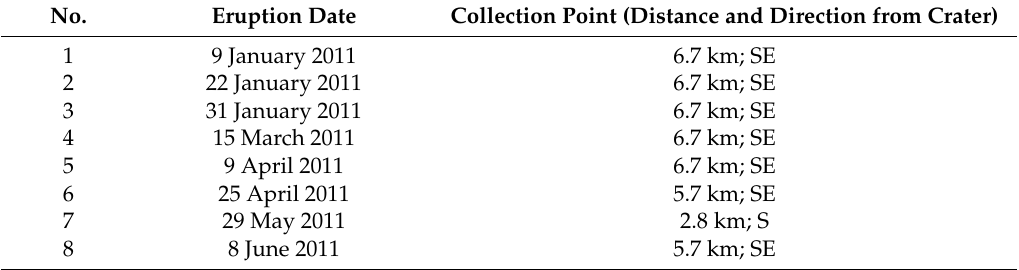
Table 1. Summary of the volcanic ash samples from January 2011 until November 2012 eruptions (*: ash samples from Japan Meteorological Agency in